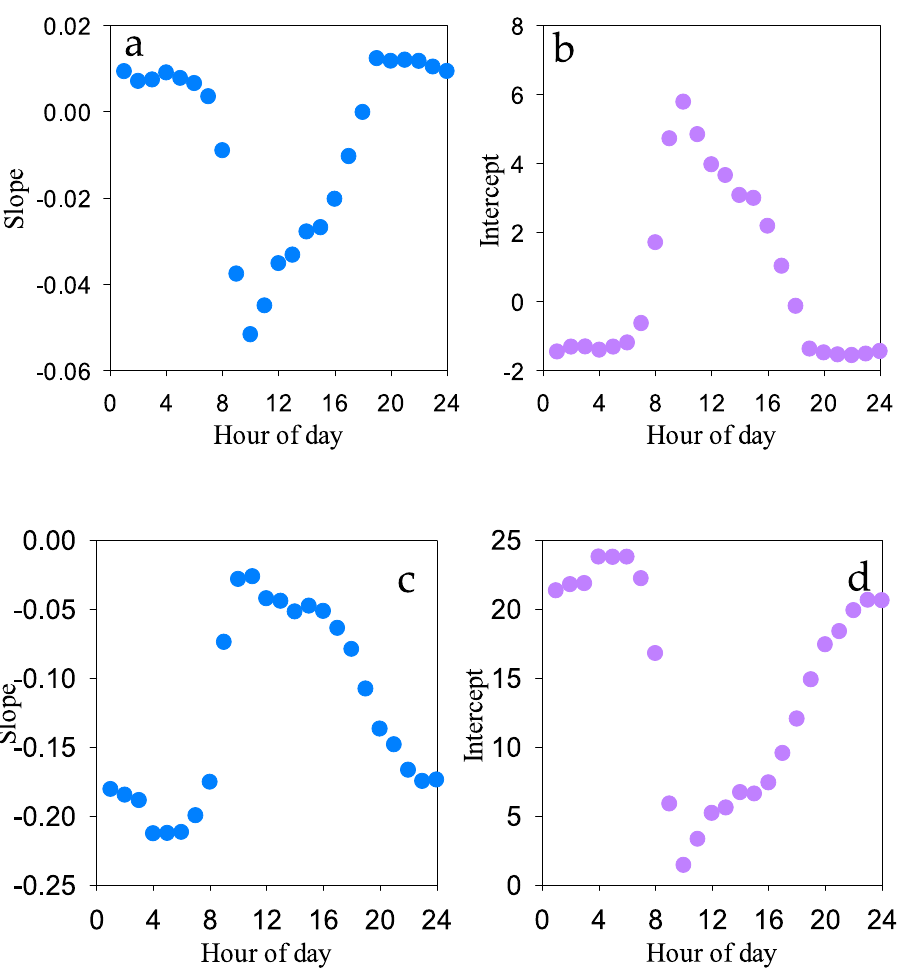
Figure 5. The slope and intercept of the linear regression of the wireless sensor-based temperature ( a , b ) and humidity ( c , d ) errors with air humidity in a diurnal cycle. The x-axis indicates the time of day (i.e., hours). The y-axis indicates the regression parameters.